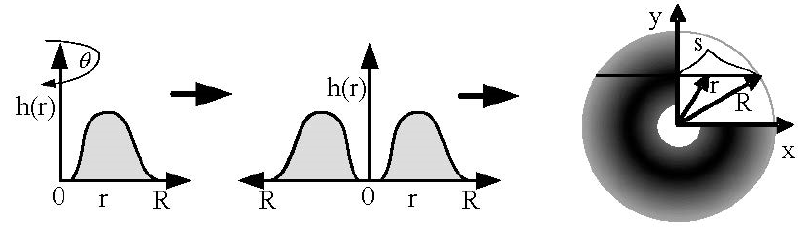
Figure 2. Spatial distribution of the circular coating formed by the rotational radial thickness profile.